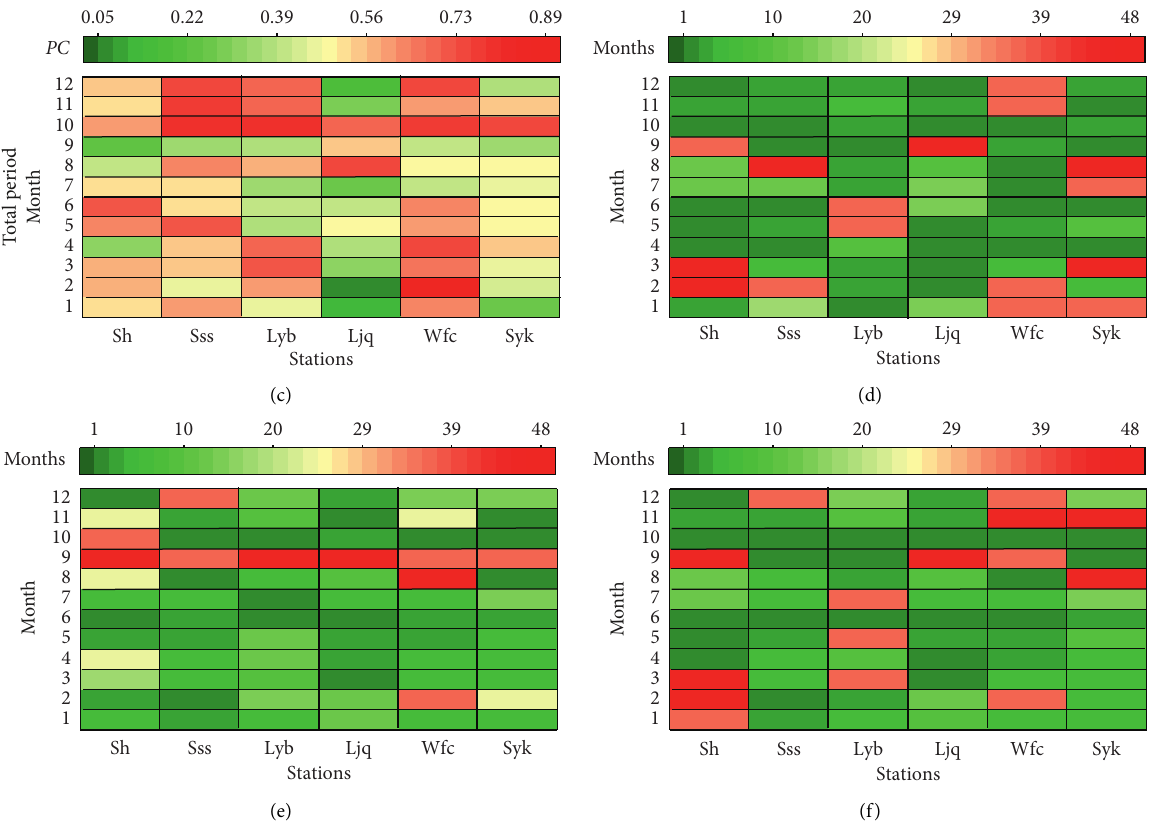
Figure 10: Intra-annual strongest PC (a–c) and the drought propagation time in months (e–f) for SPI and SDI-1 at six